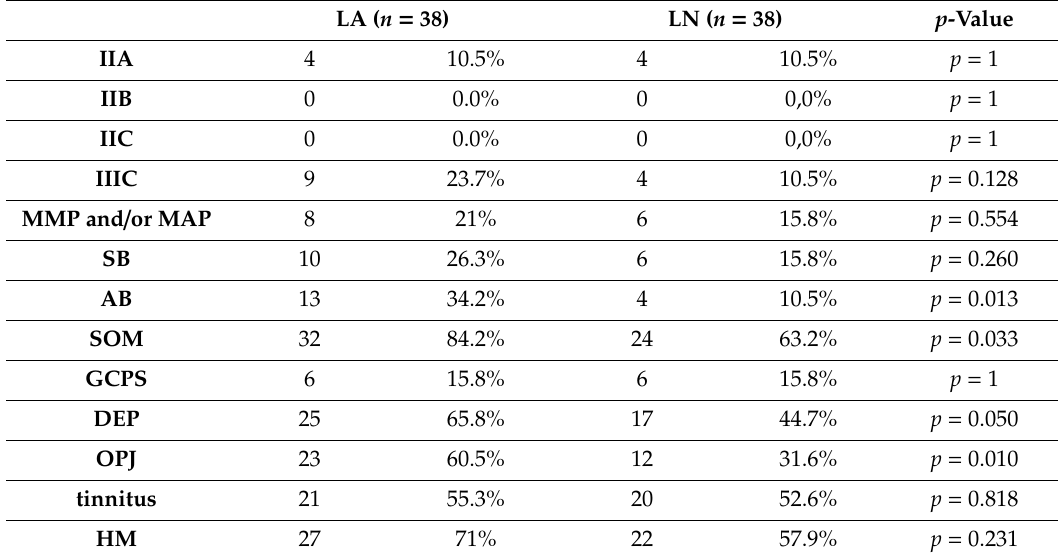
Table 2. Frequency of the RDC / TMD-based diagnosed of TMJ status, function-dependent tests and Axis II findings including SB and AB in Lyme arthritis (LA) and Lyme neuroborreliosis (LN) patients.